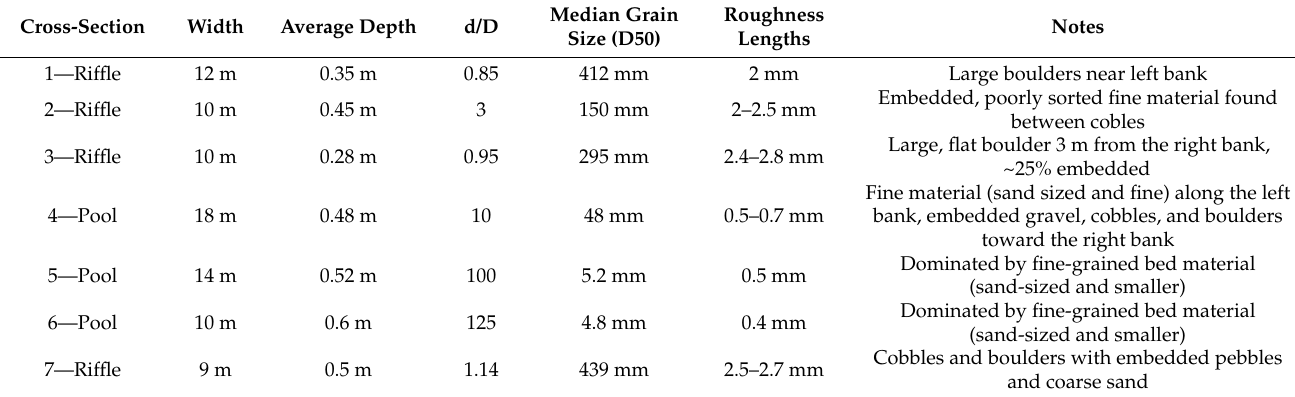
Table 1. Channel geometry and bed substrate